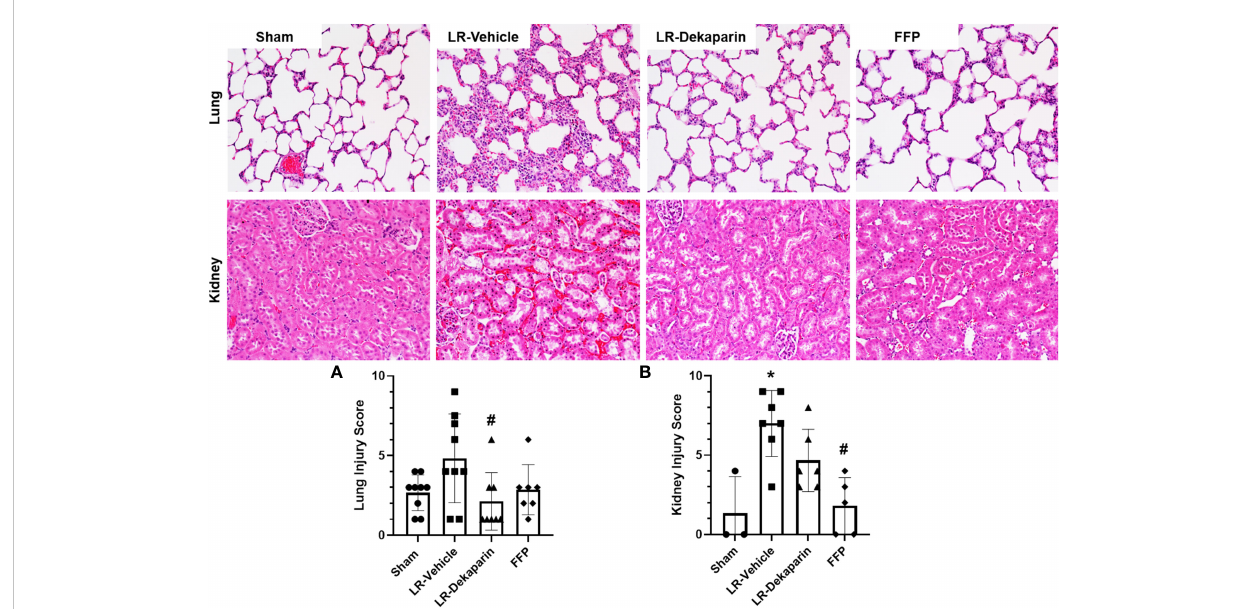
FIGURE 4 Dekaparin attenuates T/HS-induced lung and kidney injury. Lung and kidney tissue were collected after 3HR for hematoxylin and eosin (H&E) staining and assessment of organ injury by a blinded pathologist. Representative H&E-stained tissue images (20x) are provided for both lung (top) and kidney (bottom). (A) Lung and (B) kidney injury scores were quanti fi ed to compare between groups. Data are expressed as mean with standard deviation. For lungs, N=9 Sham, N=9 LR-vehicle, N=8 LR-dekaparin, N=7 FFP. For kidneys, N=3 Sham, N=7 LR-vehicle, N=6 LR-Dekaparin, N=5 FFP. N=7-9 for all groups. * denotes p<0.05 compared to sham. # denotes p<0.05 compared to LR-vehicle. LR, Lactated Ringer's; FFP, fresh frozen plasma; T/HS, trauma and hemorrhagic shock; 3HR, 3 hours after